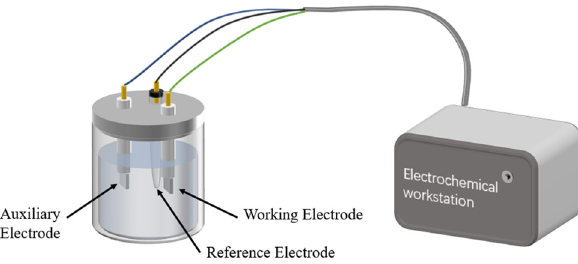
Figure 2: PTA processing schematic representation. Figure 3: Schematic diagram of the electrochemical